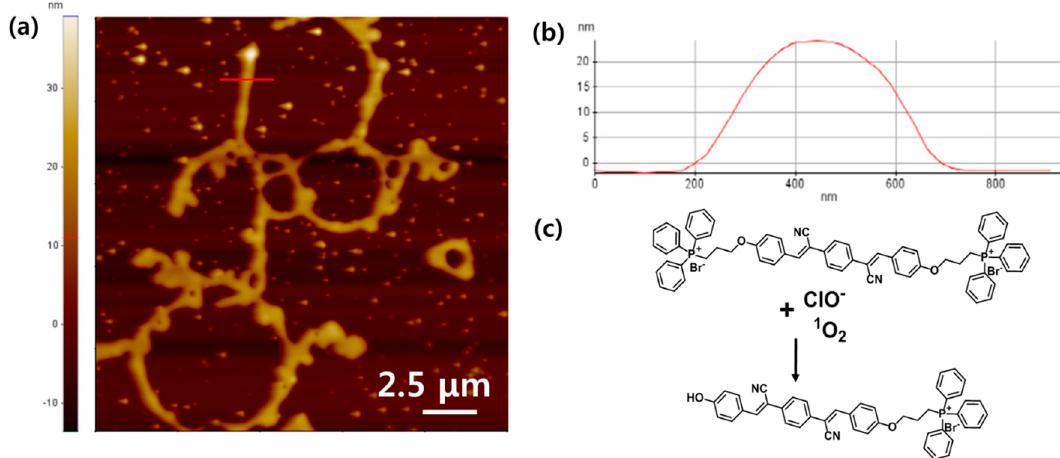
Figure 5. ( a ) AFM image of 1 (100 µ M) in DMSO/H 2 O (1/99, v / v %) after adding ClO − or 1 O 2 . ( b ) Height and width of nanofiber ( a ). ( c ) Mechanism of 1 after adding ClO − or 1 O 2 . (ClO − -treated probe 1 and 1 O 2 -treated probe 1 were shown similar morphologies).